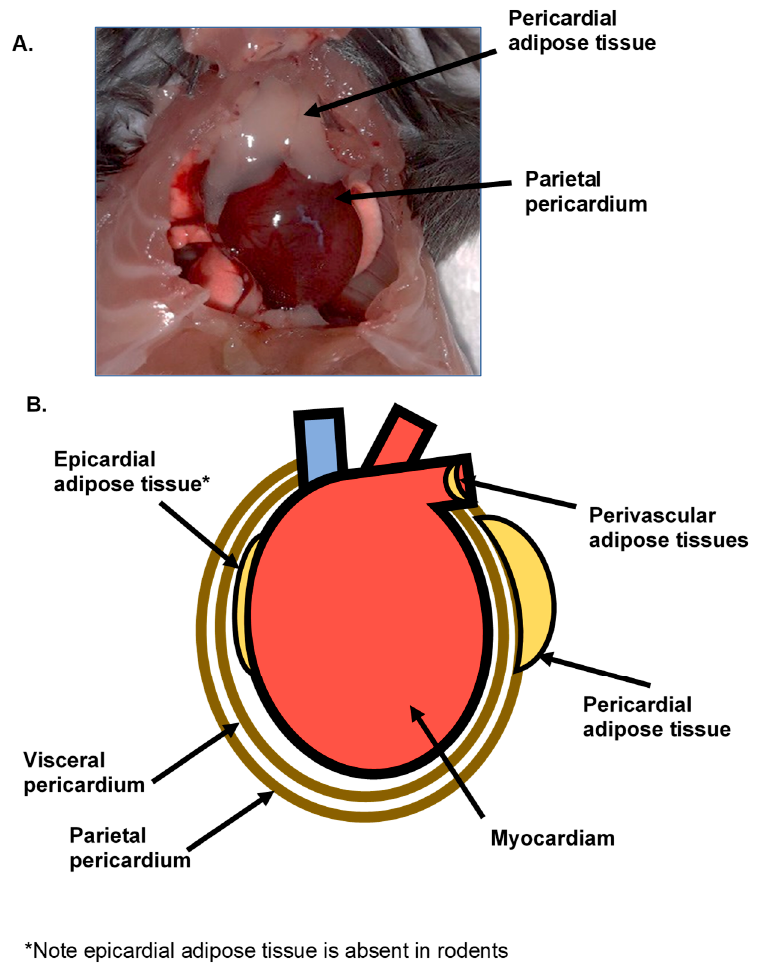
Figure 1. The location of epicardial adipose tissue (EAT), pericardial adipose tissue (PAT) and perivascular adipose tissue (PVAT) associated with the heart in rodents ( A ) and diagrammatically in humans ( B ). EAT is absent in the heart of rodents but present in the heart of human.